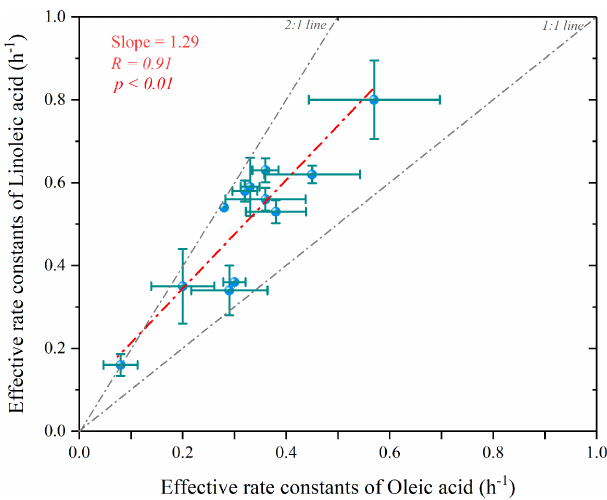
Figure 10. Scatterplot of the estimated effective rate constant for linoleic acid versus oleic acid (the p value indicates the parameter of the F test of the regression equation in the regression